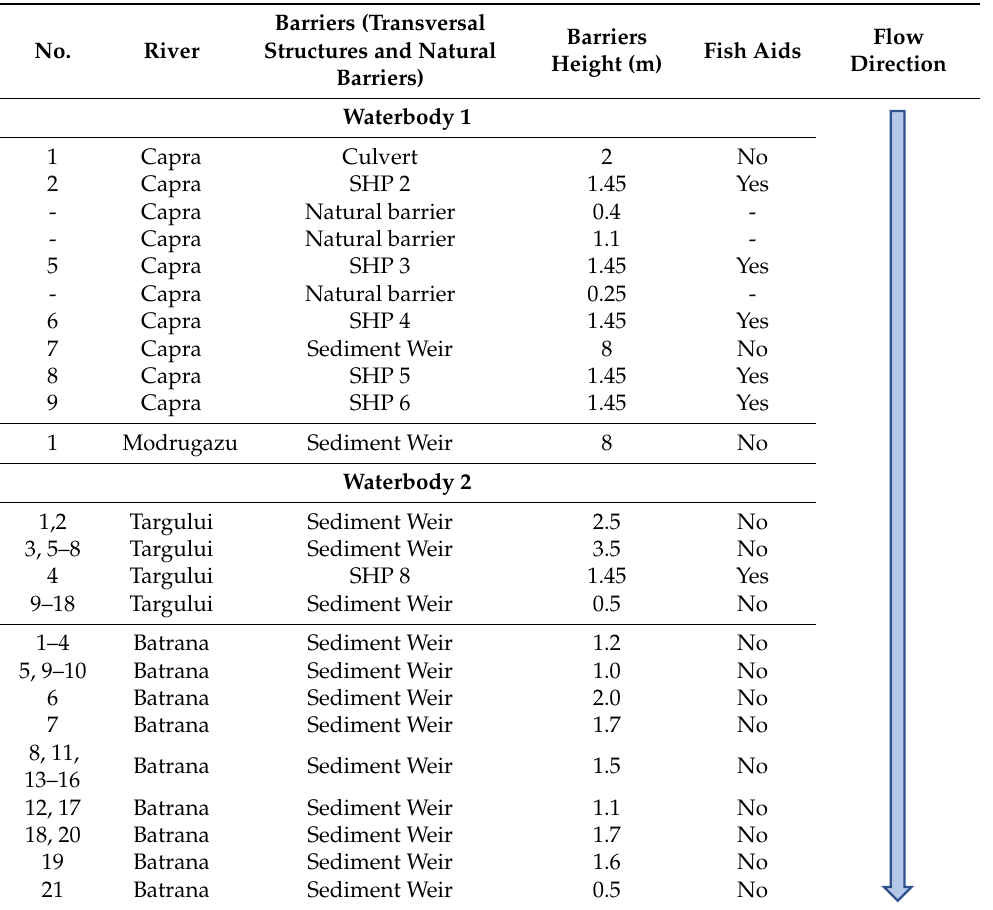
Table 4. Transversal artificial and natural barriers within the study areas.